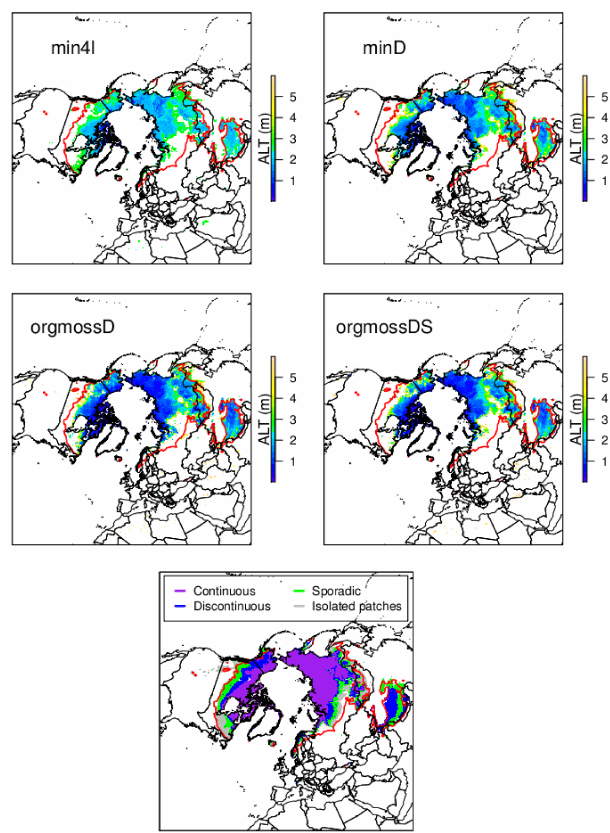
Figure 7. First two rows: mean active layer thickness in JULES simulations, 1979–1989. All grid cells with active layer ≤ 6m are shown, with mean ALT indicated by colour. Bottom: observed per- mafrost map (Brown et al., 1998), based on maps made between approximately 1960 and 1990. On all plots the 0 ◦ air temperature isotherm is shown in red (1979–1989 from WFDEI air temperature, see Sect.